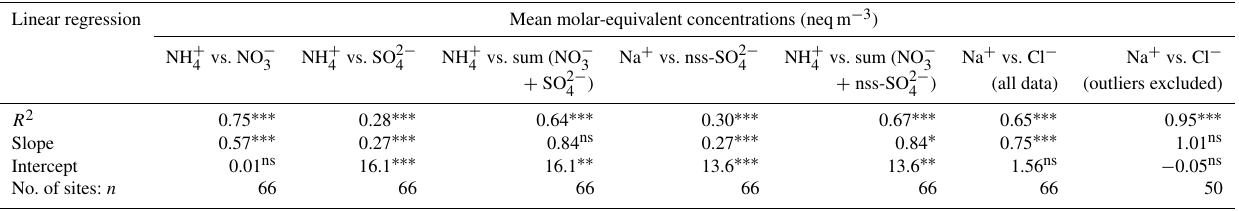
Table 7. Linear regressions between the mean molar-equivalent concentrations of aerosol components (nanoequivalent, neqm − 3 ) at sites ( n = 66) in the NEU DELTA ® network. Linear regression Mean molar-equivalent concentrations (neqm − 3 )